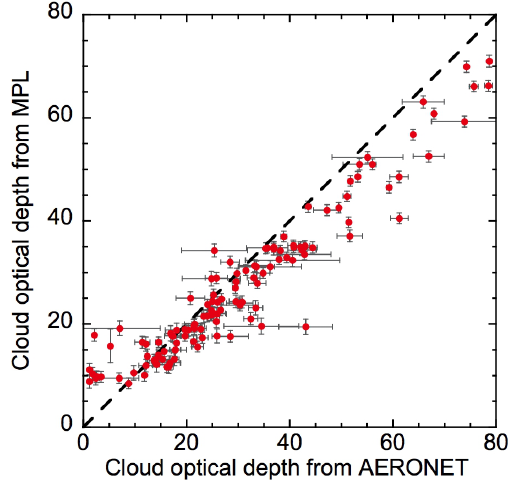
Figure 7. Scatter plot for intercomparison of cloud optical depths retrieved from solar background signals received by micropulse li- dar (MPL) and those from the AERONET cloud-mode product. The error bars represent 1 standard deviation of retrievals, while the black dashed line represents the 1:1 line.